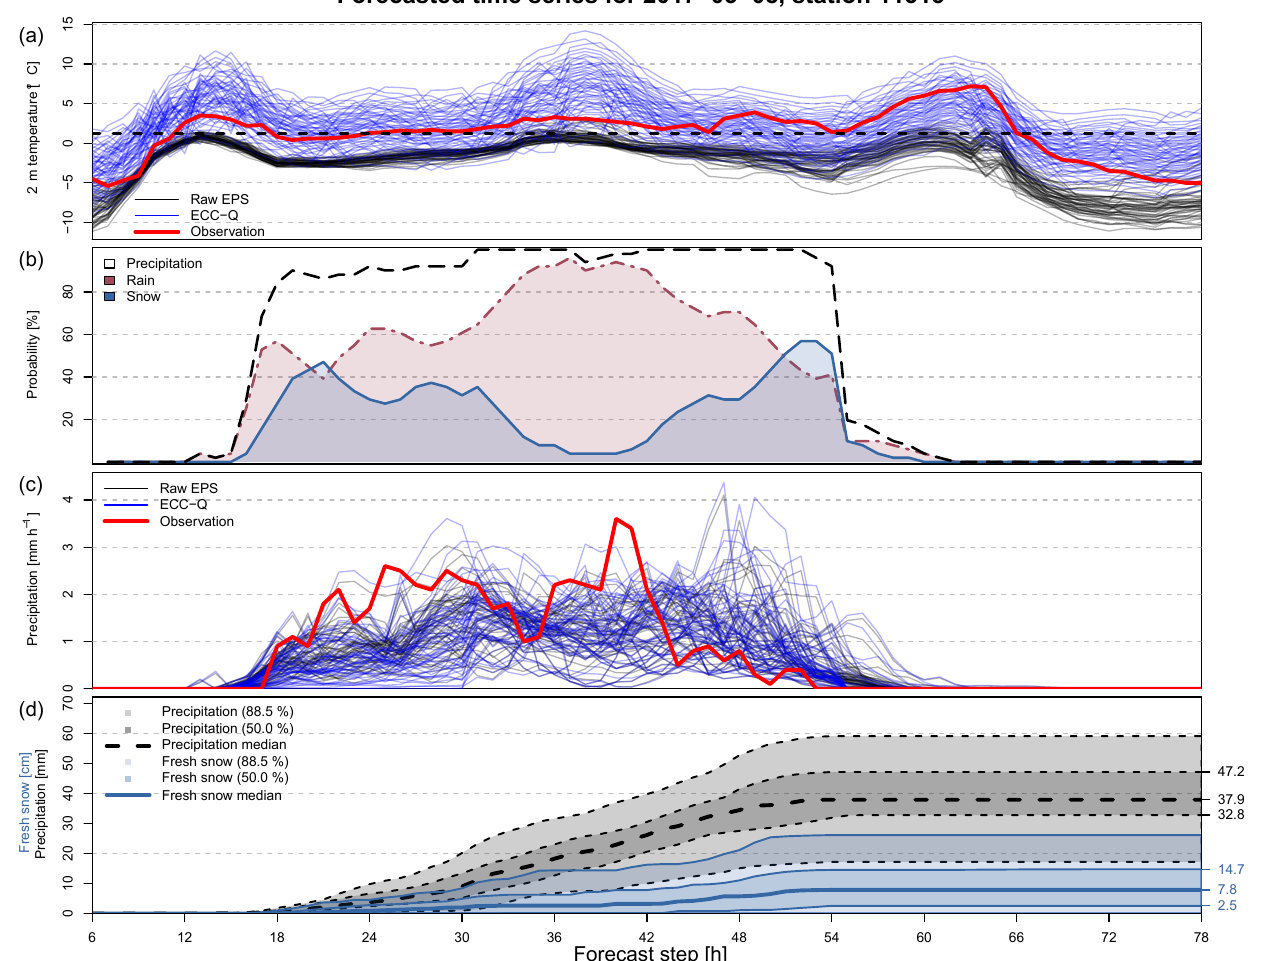
Figure 9. Example prediction for 8 March 2017 (station 11315, Holzgau) for the whole forecast horizon + 6 up to + 78h ahead. (a) Raw EPS forecast (black), postprocessed copula (blue), and observation (red; bold) for 2m temperature. The black dashed line is the 1.2 ◦ C line used for precipitation type classification. (b) Probability of snow (blue solid), rain (red dotdash), and precipitation (snow ∨ rain; black dashed). (c) Hourly precipitation forecasts and observations as in panel (a) . (d) Postprocessed forecasts for precipitation sum (dashed; mm), and fresh snow height (solid; cm) using the 1 : 10 rule (snow density of 100kgm − 3 ). Predicted medians, predicted 50% intervals, and predicted 88.5% intervals are